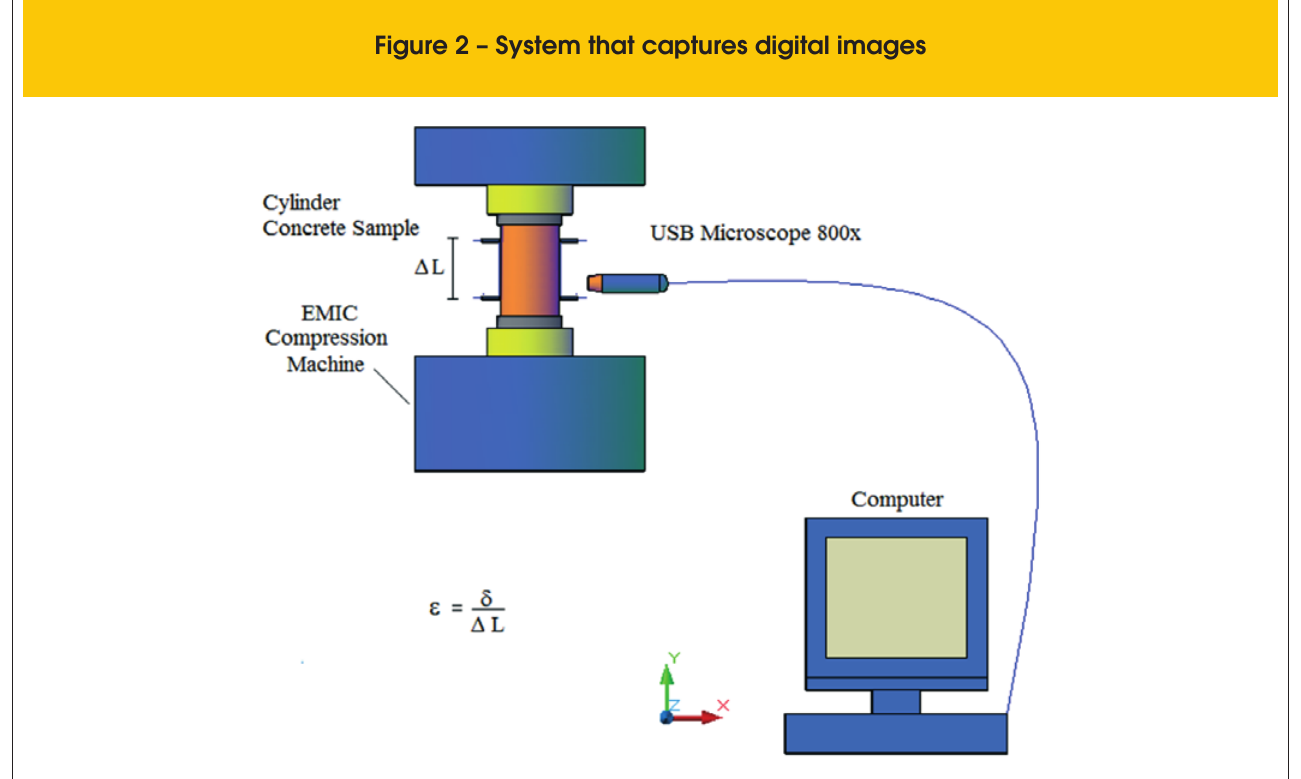
Figure 2 – System that captures digital